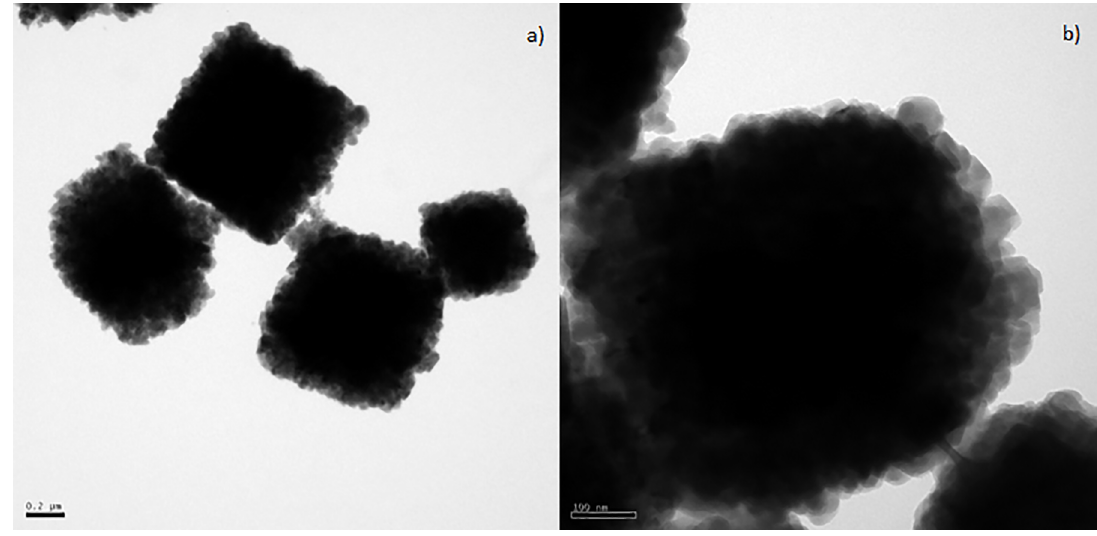
Figure 5. TEM images of the H-ZSM-12 zeolites. Table 4. Total acidity and quantity of weak and strong acid